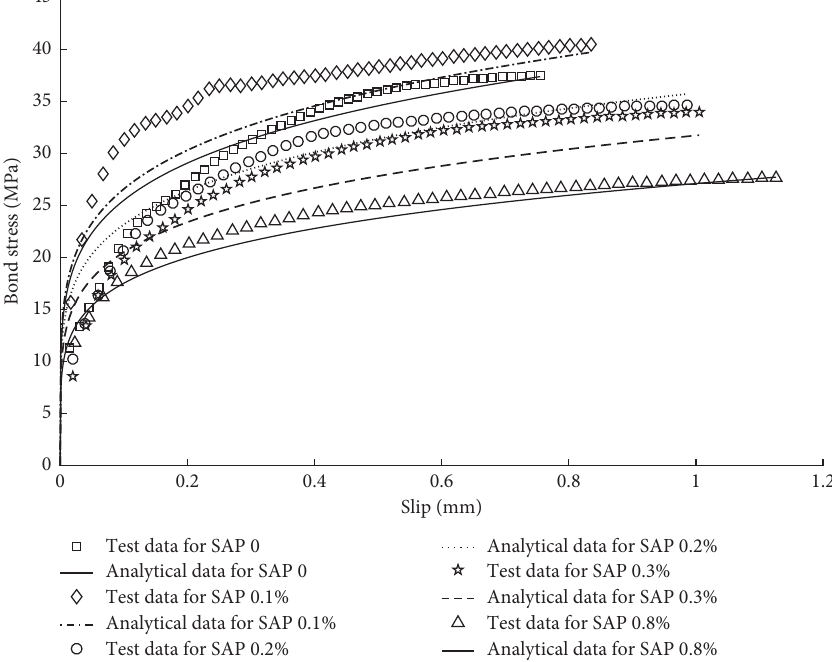
Figure 10: Theoretical and practical comparison of bond behavior of concrete mixed with